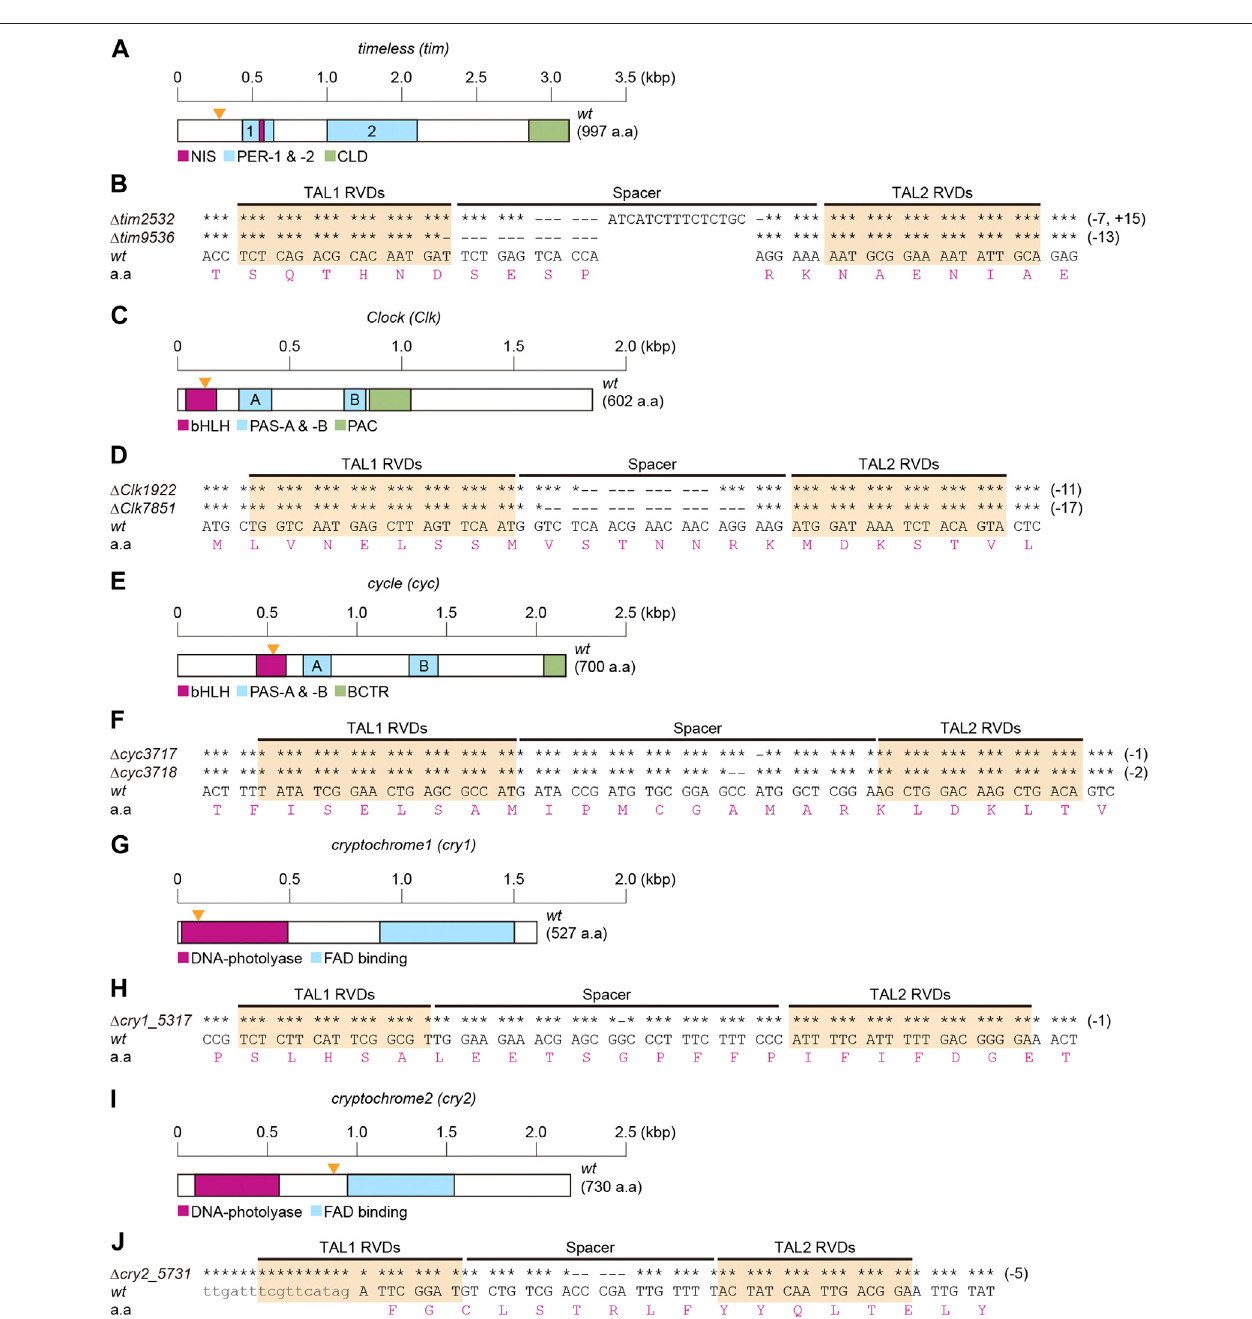
FIGURE 1 | Construction of clock gene knockout mutants. Clock genes include timeless [ tim ] (A,B) , Clock [ Clk ] (C,D) , cycle [ cyc ] (E,F) , cryptochrome1 [ cry1 ] (G,H) ,and crtyptochrome2 [ cry2 ] (I,J) .SchematicrepresentationsofthecodingregionsofeachcDNAstructureareshown in A,C,E,G,I . (A) Functionaldomains ofTIM, NIS(nuclearlocalizationsignal),PER(PERdimerizationdomain)-1and-2,andCLD(cytoplasmiclocalizationdomain)arerepresentedasreferredinIwaietal.(2006),and Tomioka and Matsumoto (2015). (C) Functional domains of CLK, bHLH (basic helix-loop-helix), PAS (Per-Arnt-Singleminded)-A and -B, and PAC are represented as referred in Ponting and Aravind (1997), Allada et al. (1998), and Moriyama et al. (2012). (E) Functional domains of CYC, bHLH, PAS-A and -B, and BCTR (BMAL1 C-terminal region) are represented according to Markova et al. (2003), Kamae et al., 2010, and Uryu et al. (2013). (G,I) Functional domains ofCRY1 and CRY2, DNA-photolyase, and FAD ( fl avin adenine dinucleotide) binding are represented by searching the InterPro (http://www.ebi.ac.uk/interpro/) database and as referred in Tokuoka et al. (2017). The sizes of cDNA are indicated by scales in each map (A,C,E,G,I) . Hyphens indicate the deleted bases in spacer and TAL RDV regions of each mutant, and identical bases are indicated by asterisks (B,D,F,H,J) .